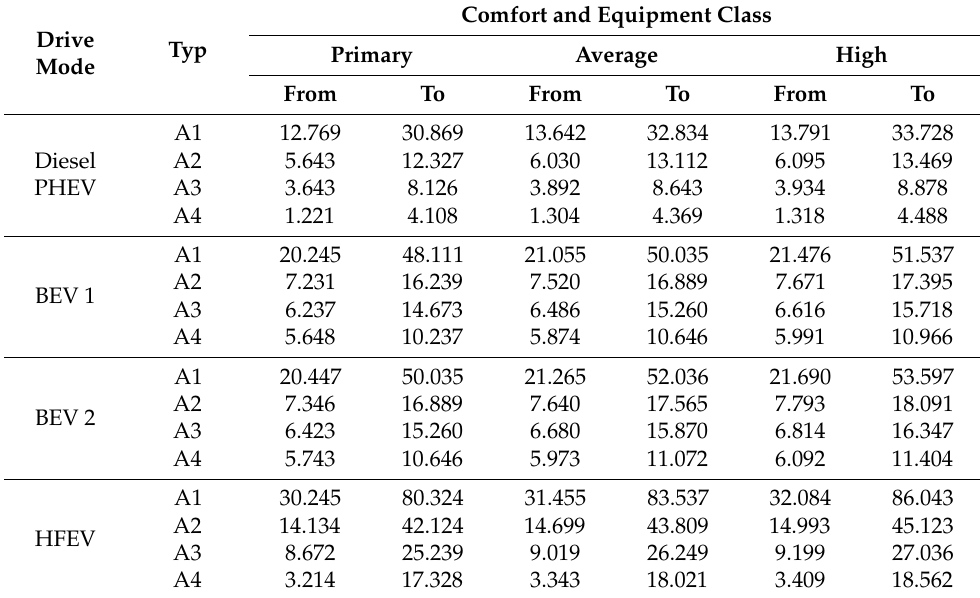
Differential Total Cost of Ownership of DTCO for Given Vehicle Groups Compared to the